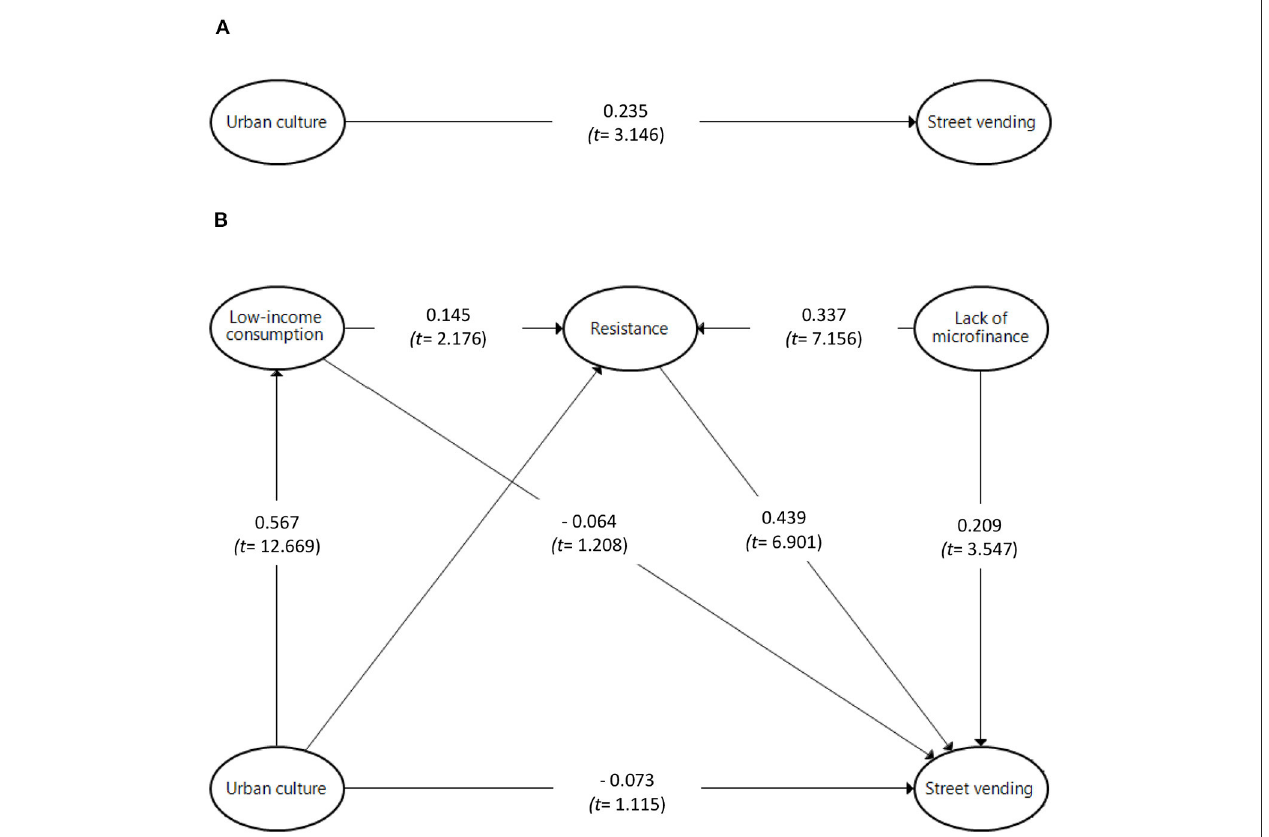
FIGURE 2 | Structural model results. (A) Model with total effect. (B) Model with double